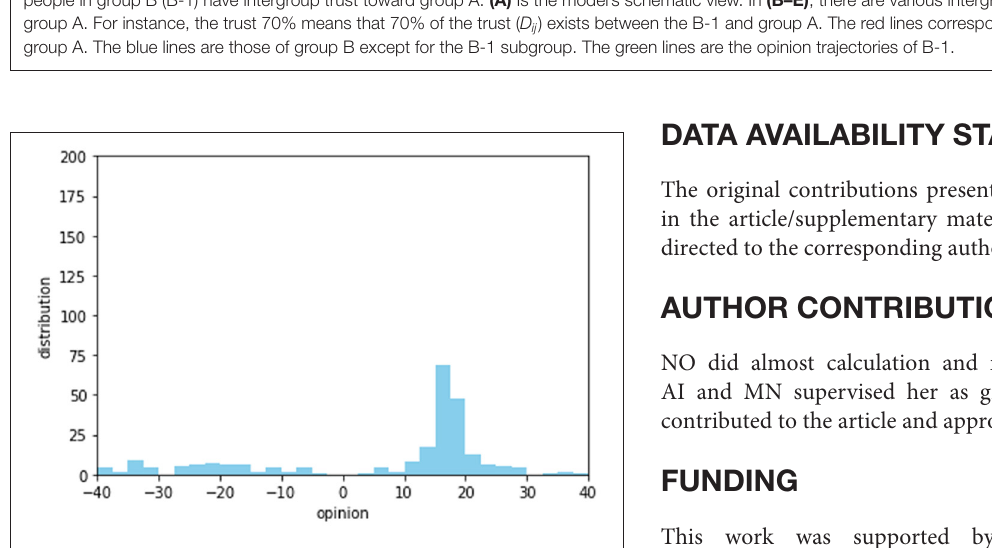
FIGURE 9 | Opinion distribution for the case shown in Figure 8E at time =